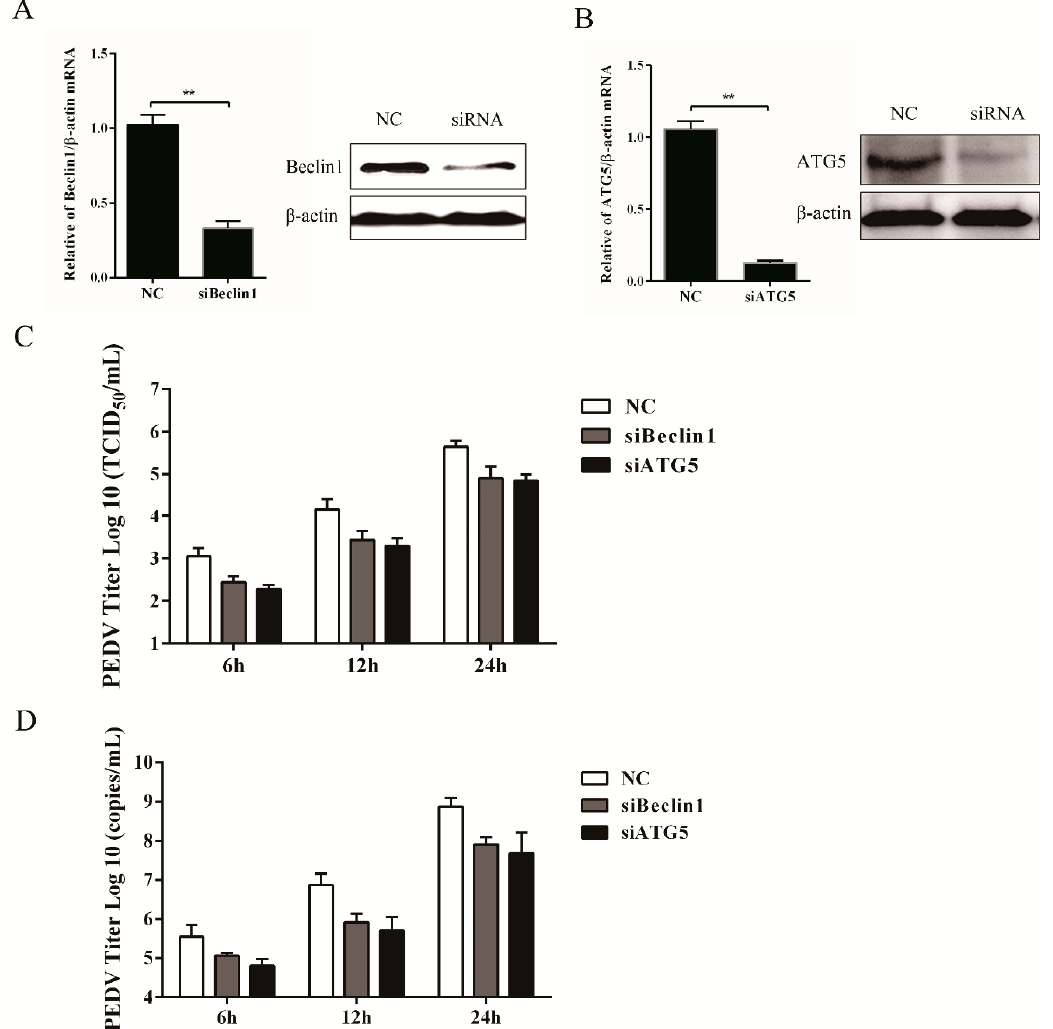
Figure 5. Inhibition of autophagy with specific siRNA targeting Beclin1 or ATG5 reduces PEDV replication. ( A , B ) Vero cells were transfected with siRNA targeting Beclin1 , ATG5 , or negative control (NC) for 48 h. The silencing efficiency was determined separately by quantitative real ‐ time PCR and Western blot. ( C ) At 24 h post ‐ transfection, cells were mock ‐ infected or infected with PEDV for another 6, 12, and 24 h. The virus titer was determined by TCID 50 . The data were presented as mean ± SEM of three independent experiments. ( D ) The cells were treated as described in ( C ) and collected separately at 6, 12, and 24 hpi, respectively. The virus copy number was determined by qRT ‐ PCR. The data were presented as mean ± SEM of three independent experiments.